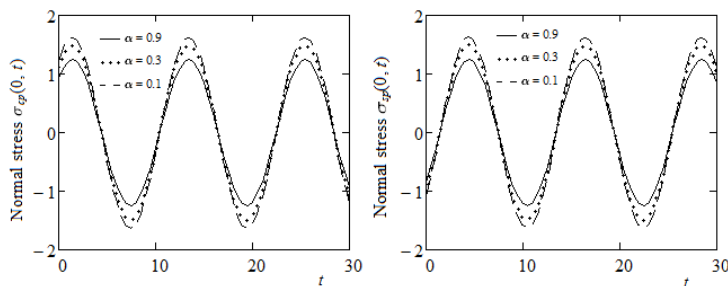
Figure 6. Time variations of the normal stresses σ cp ( 0, t ) and σ sp ( 0, t ) on the bottom plate for Re = 100,We = 1, ω = π /12 and decreasing values of α .